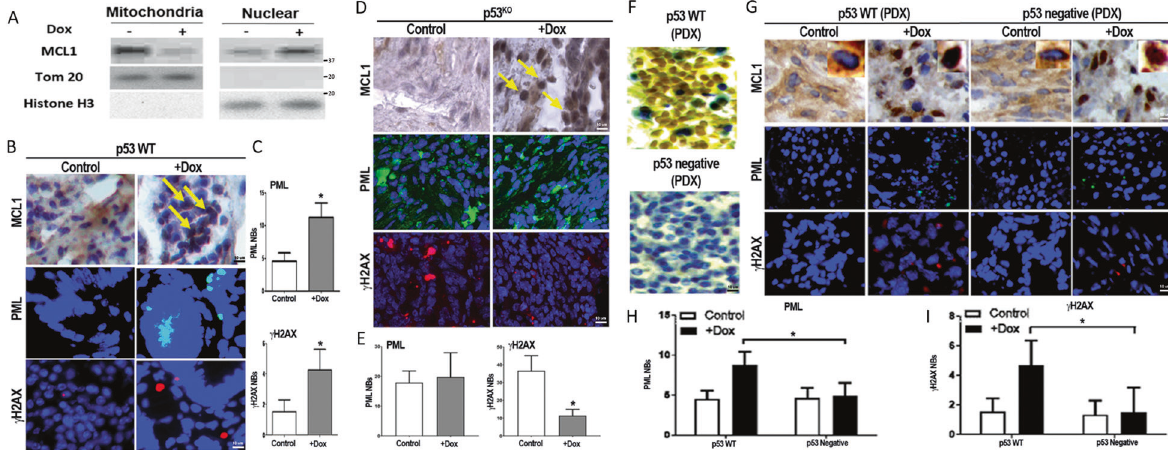
Fig. 2 Chemotherapy treatment induces MCL1 protein nuclear translocation in In fl ammatory CRC mouse model and PDX. A Mitochondria extraction and nuclear extraction were isolated from CRC mouse model treated with doxorubicin 1.2 mg/kg. No drug treatment was used as control. Western blot was used to detect the protein level of MCL1. Tom 20 was used as an indicator of mitochondria and Histone H3 was used as an indicator of the nucleus. Data are representative of two independent experiments. B Representation of microscopy images of in fl ammatory CRC mouse model. Tissues were stained with MCL1, PML, and γ H2AX nuclear bodies. Yellow arrows show the nucleus located MCL1 proteins. C Quantitative analysis of chemotherapy-induced senescence (CIS) in CRC mouse model and analyzed for PML and γ H2AX nuclear bodies. * p < 0.05 for the indicated doxorubicin treated tumor compared with no drug treatment controls. Error bars represent + / − S.D. D Representation of immuno fl uorescence microscopy images of p53 KO tumors with or without doxorubicin treatment. Tissues were stained with MCL1, PML, and γ H2AX nuclear bodies. E Quantitative analysis of CIS in p53 KO model for PML and γ H2AX nuclear bodies. T-test was performed to calculate p values, *, p < 0.05. F Representation of microscopy images of PDX model with wild type and p53 negative. The tissue was stained with anti-p53 antibodies. G Representation of microscopy images of PDX models. After injected with CRC cells, mice received 1.2 mg/kg doxorubicin every 3 days or were left untreated. Tissues were stained with MCL1, PML, and γ H2AX nuclear bodies. The staining of MCL1 protein in single cells was shown in an enlarged picture on the top of the right side within each represented data. H, I Quantitative analysis of CIS in PDX model and analyzed for, PML and γ H2AX nuclear bodies. Error bar represent + / − S.D. T-test was used to calculate the p values, *, p < 0.05 for the indicated doxorubicin treated PDX with and without wild type p53.